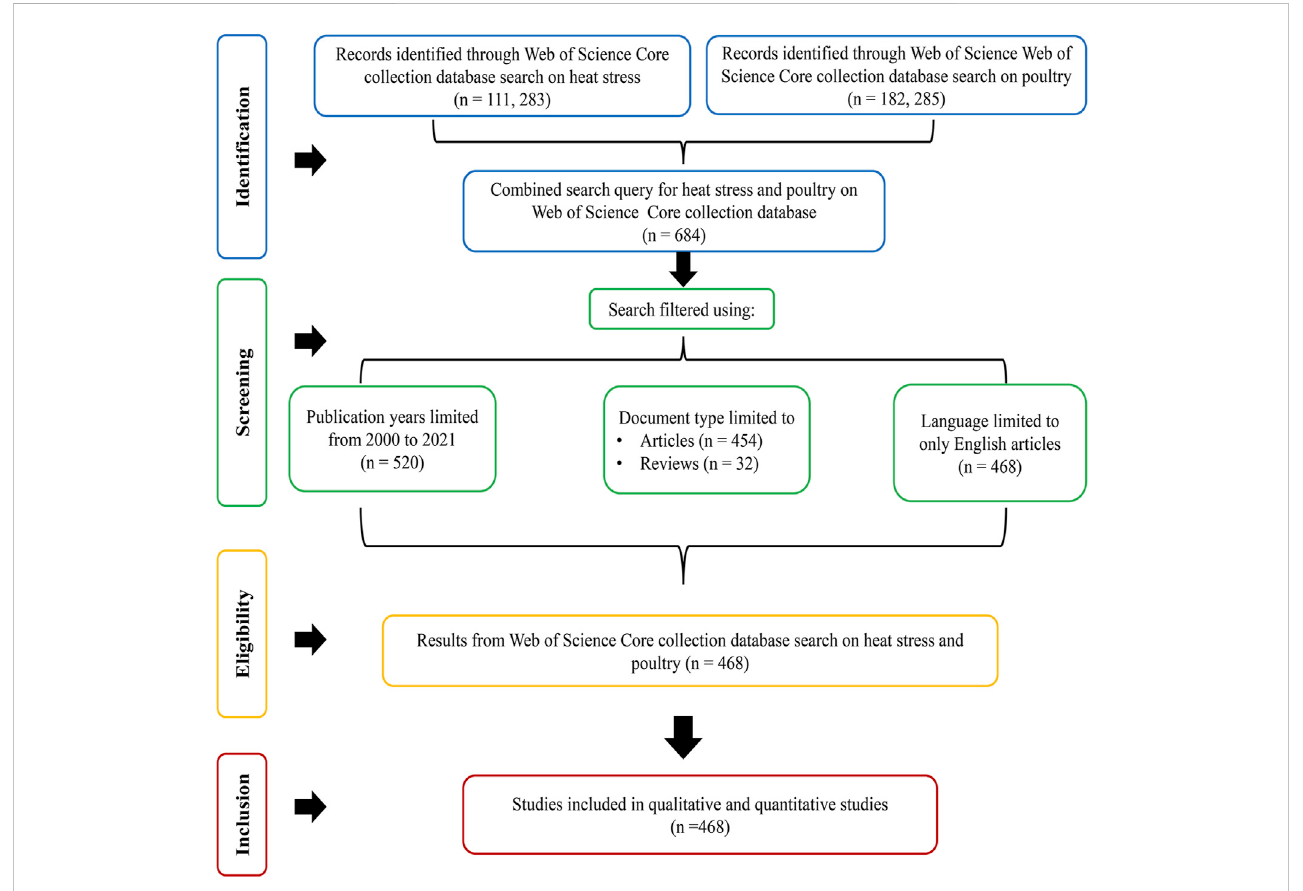
FIGURE 1 Schematic illustration of the search strategy conducted to retrieve published articles on heat stress in poultry from 2000 to 2021.